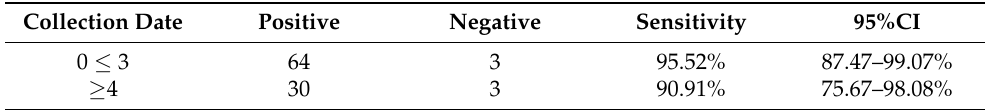
Table 6. Clinical sensitivity of the GenBody COVID-19 Ag test (COVAG025) based on